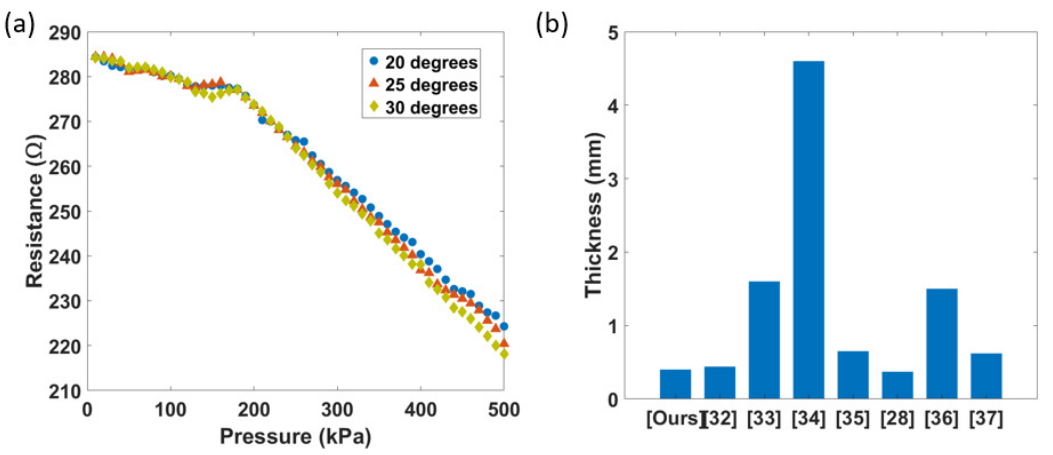
Figure 8. ( a ) Resistance change at di ff erent temperatures and ( b ) Comparison of the thickness with other studies.